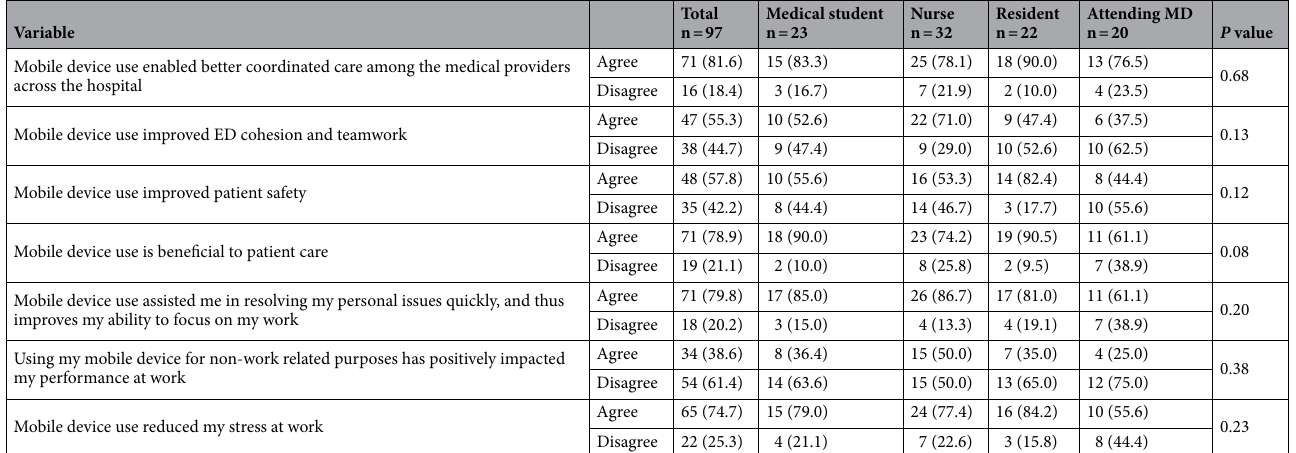
Table 4. Personal and professional attitudes of HCPs towards mobile device use stratified by category a . a Cell counts may not add up to the raw total due to missing responses in the